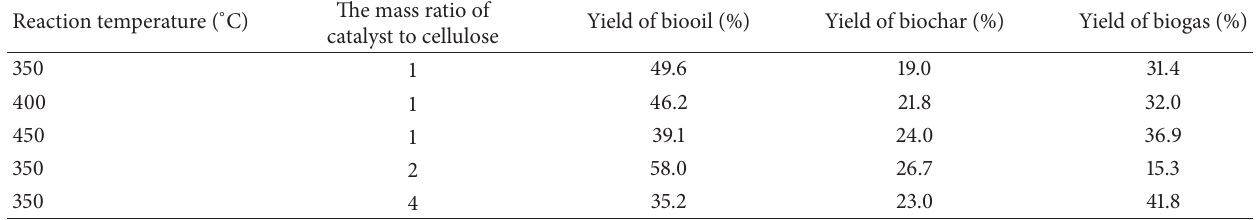
Table 4: The yield of biooil, biogas, and biochar produced from cellulose pyrolysis catalyzed by FePO 4 under different reaction conditions. Reaction temperature ( ∘ C)